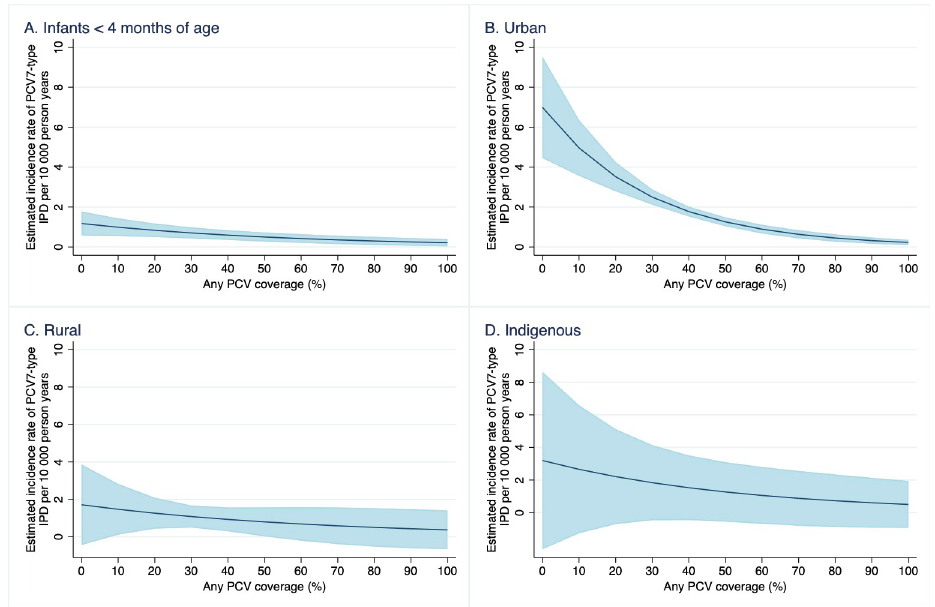
Fig 5. Estimated rate of VT IPD incidence � and 95% CIs (blue shading) among 3 subgroups of undervaccinated children under 5 years (urban, rural, and Indigenous), at each decile of PCV coverage, New South Wales and Western Australia, 2001–2012. CI, confidence interval; IPD, invasive pneumococcal disease; PCV, pneumococcal conjugate vaccine; PCV7, 7-valent PCV; VT,